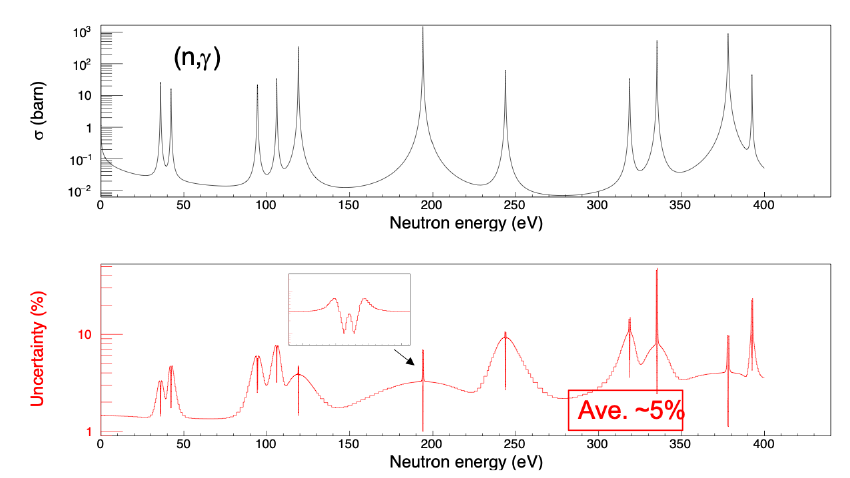
Figure 6. 93 Nb(n, γ ) cross section (top) and corresponding relative uncertainty in percent